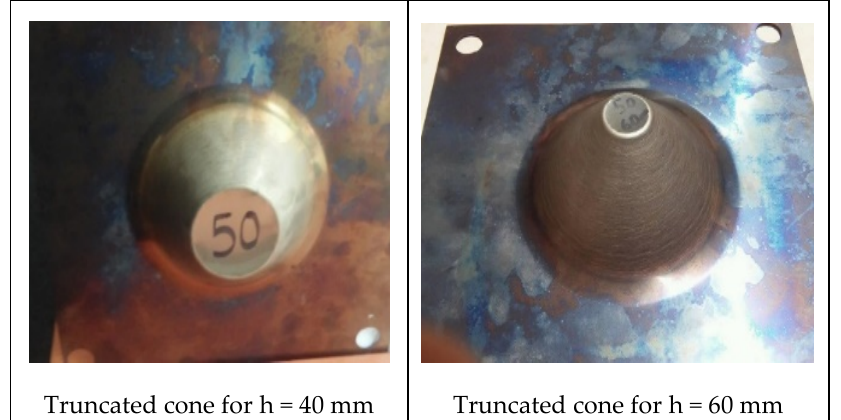
Figure 7. Experimental deformed truncated cone for α = 50°, h = 40 mm, and h = 60 mm. 3.1. Measurement of Deformed and Thickness Profile of the Deformed Truncated Cone Four cutting planes (Plane 1, Plane 2, Plane 3, and Plane 4) were defined to perform a palpation and scan of the formed truncated cone surfaces (top and bottom), as shown in Figure 8. A measuring program is developed using Coordinate-Measuring Machine, which made it possible to carry out measurements on the upper surface and the inner surface of the truncated cone.